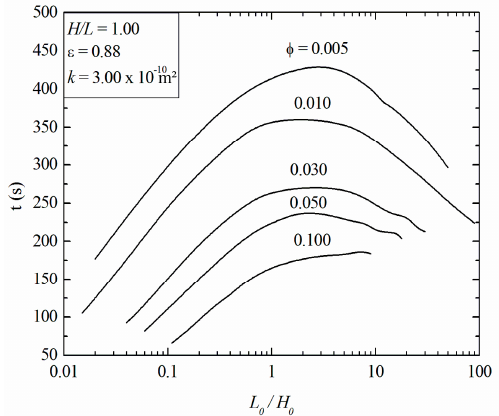
Figure 5. E ff ect of the L 0 / H 0 ratio over resin infusion filling time for di ff erent area fractions of the Figure 5. Effect of the L 0 / H 0 ratio over resin infusion filling time for different area fractions of the I- I-shaped empty channels. shaped empty channels.